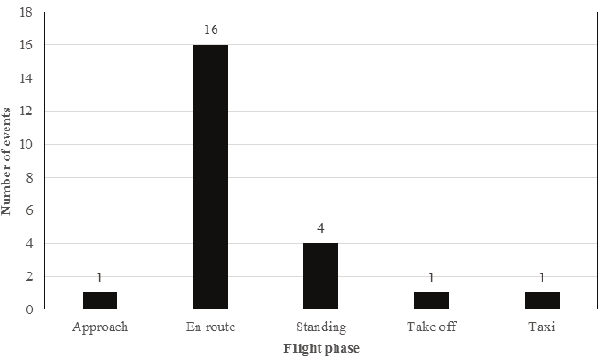
Fig. 12. Design scheme of PT6 turboprop engine: 1 – air inlet, 2 – com- Fig. 11. Flight phases share when powerplant malfunction in the ATA 79 pressor, 3 – combustor chamber, 4 – compressor powered turbine, 4’ – chapter took place